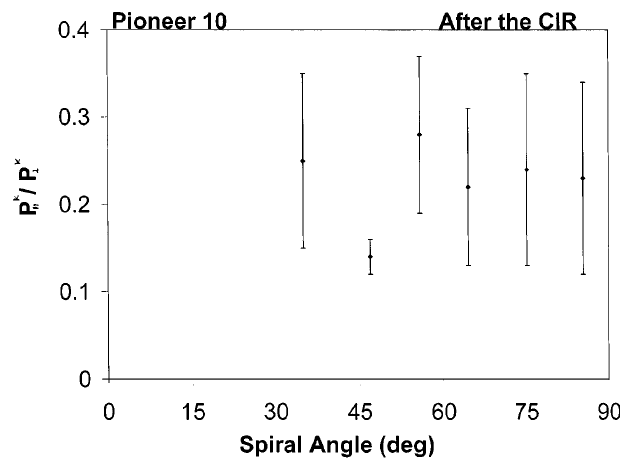
Fig. 8. Ratio of parallel and perpendicular spectra as a function of the spiral angle for the interval of time after the CIR, according to